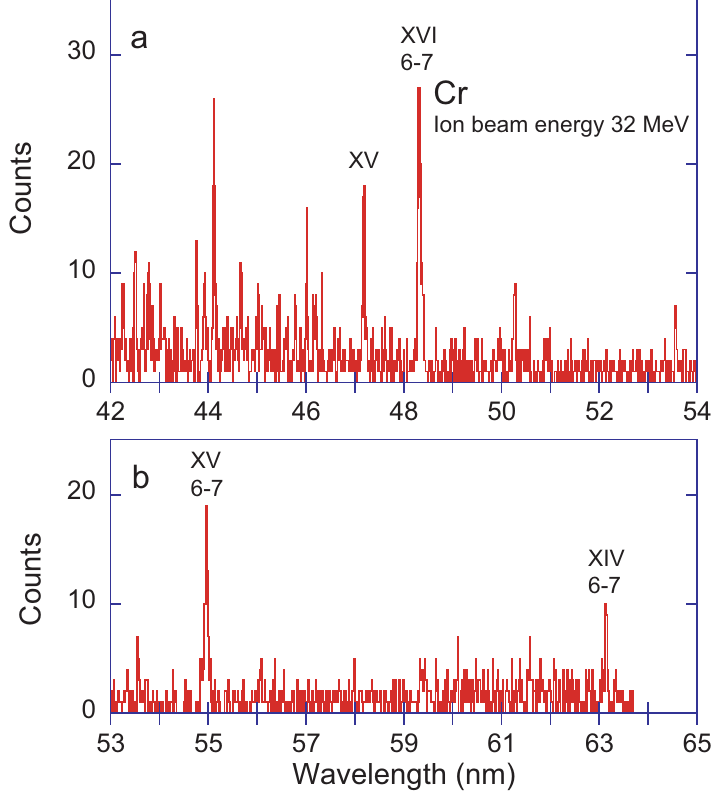
Figure 15. Two sections ( a,b ) of a beam-foil spectrum of Cr recorded at an ion beam energy of 32MeV (continuation of the spectra in Figure 14). The strongest lines are identified by the spectrum number. Observation at the foil. Line width (FWHM) 0.035nm. Several spectral features can be identified with n = 6–7 yrast transition